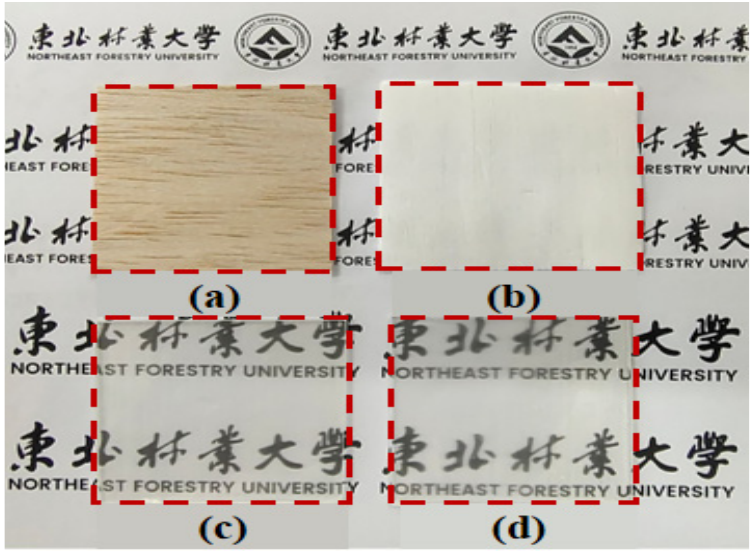
Figure 6. Pictures of wood samples during experimental treatment: ( a ) Pristine wood, ( b ) Lignin-modified wood, ( c ) Optically transparent wood, ( d ) Hydrophobic transparent wood. The photo was taken by placing the sample on the emblem of Northeast Forestry University.